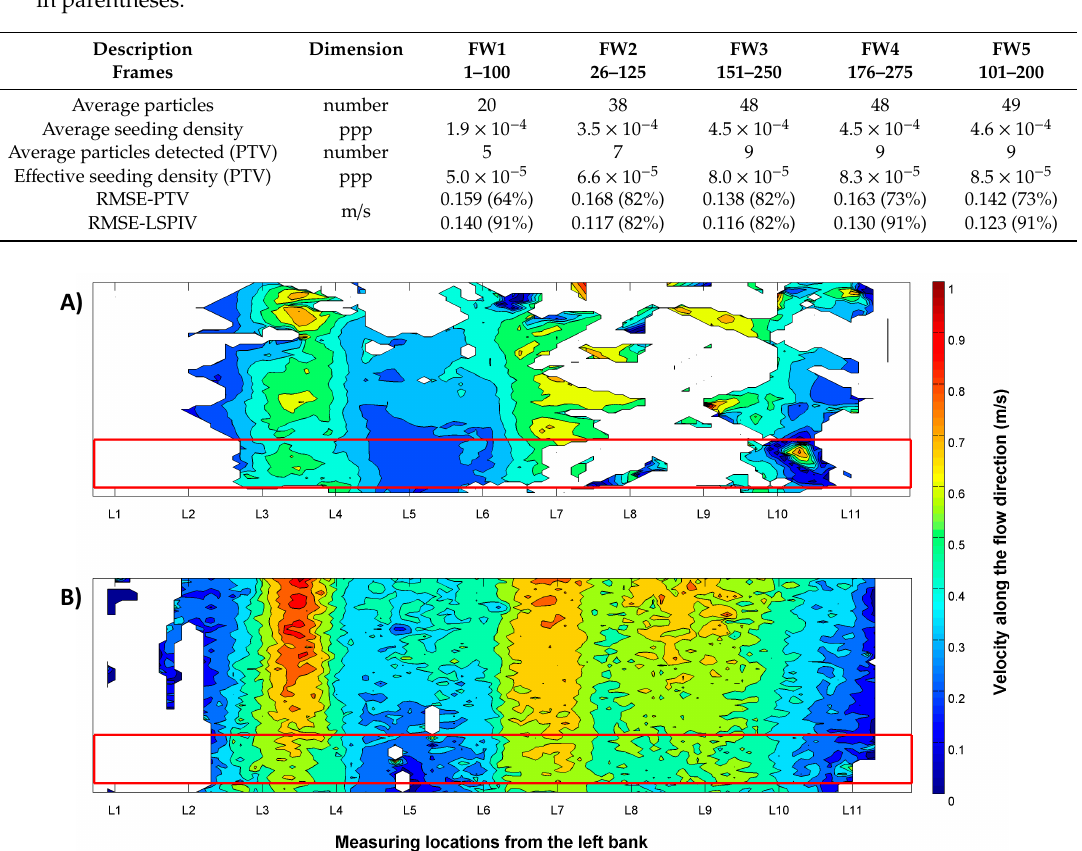
Figure 10. Examples of flow velocity maps calculated using ( A ) PTV and ( B ) LSPIV algorithms on FW3 of the Basento River. Red squares represent ROI considered for the analysis.